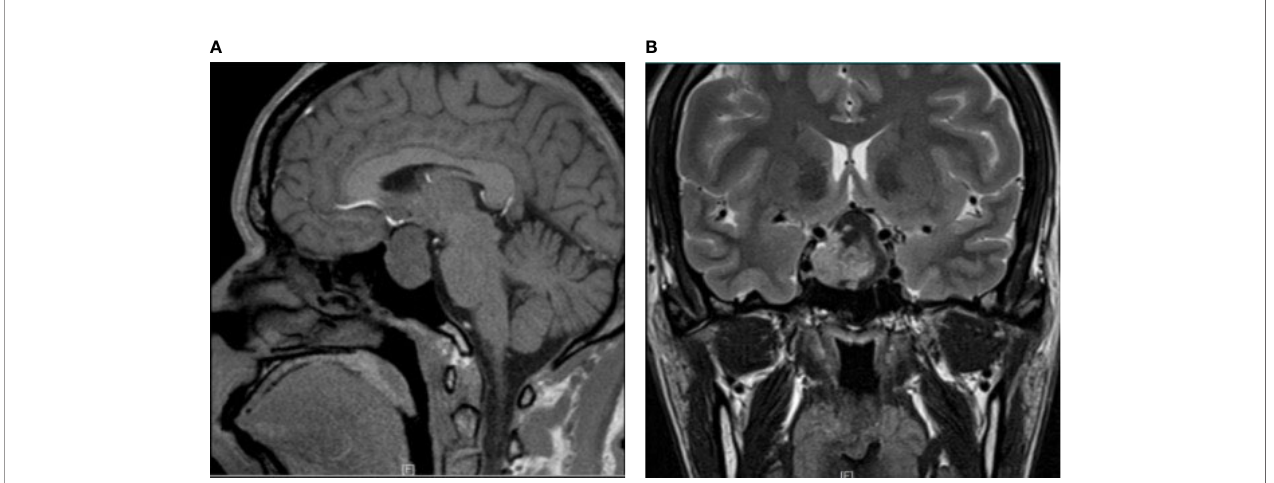
FIGURE 1 | Radiological image of mixed gangliocytoma-pituitary adenoma. (A) Preoperative MRI shows a lesion with sagittal hypointensity on T1-weighted imaging. (B) T2-weighted coronal contrast imaging shows a hyperintensity signal with a prominent waist sign. The tumor passed the tangent of the medial aspects of the intracavernous and supracavernous internal carotid arteries, but did not extend beyond the intercarotid line.